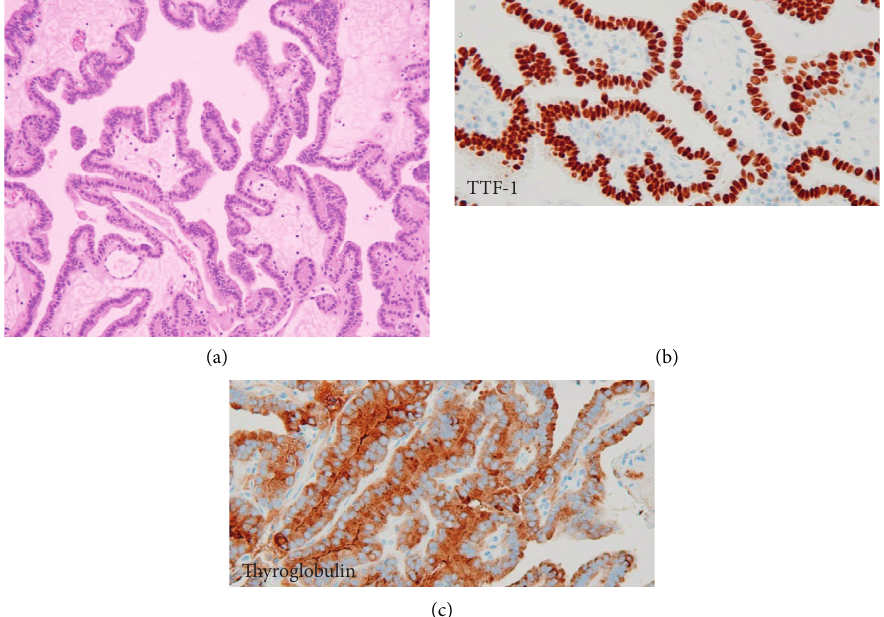
Figure 4: (a) Papillary structure. Cell nuclei are slightly larger with coarsely granular chromatin (hematoxylin and eosin, 100 × ). (b, c) Immunohistochemical staining revealed tumor cells positive for thyroid transcription factor 1 (TTF-1) (positive for carcinoma arising from follicular epithelial cells) and